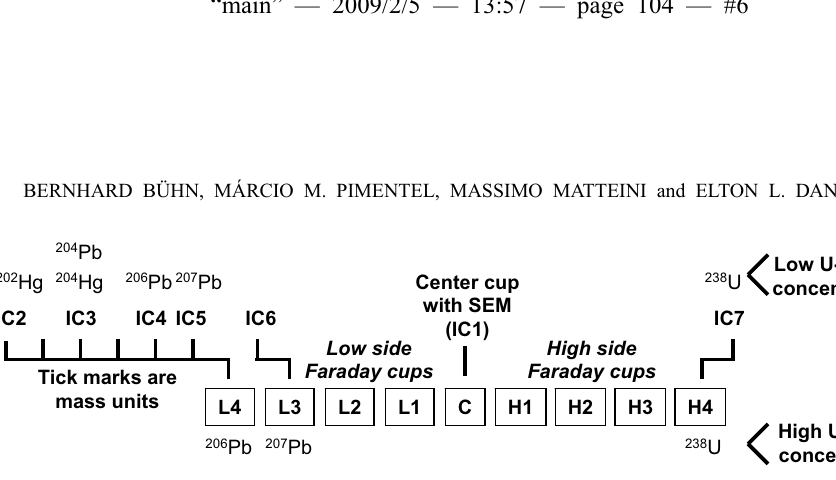
Fig. 2 – Set-up of the cup configurations (Faraday cups and ICs) for low U-Pb and high U-Pb concentrations in zircon with the Thermo Finnigan Neptune